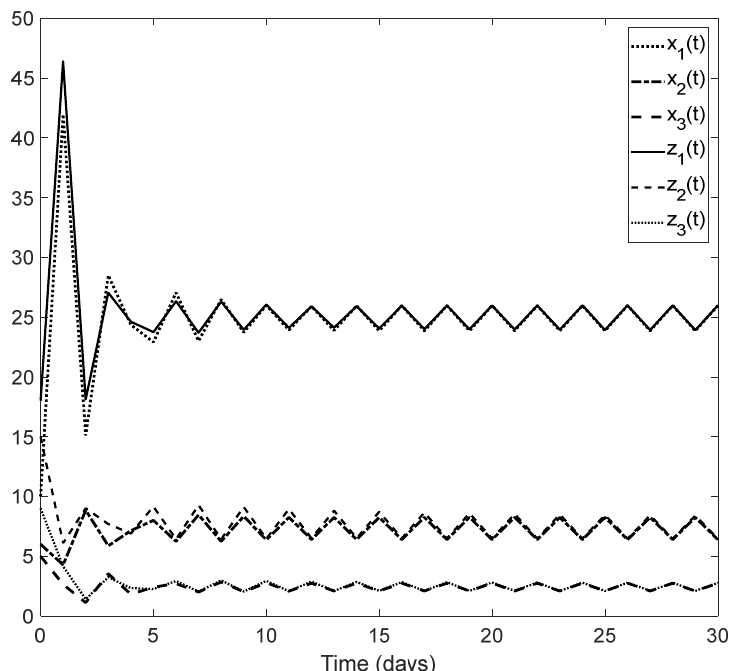
Figure 6. Estimation of the state process, under the effect of an unknown periodic environmental change, using an observer corresponding to the system extended with the exosystem.